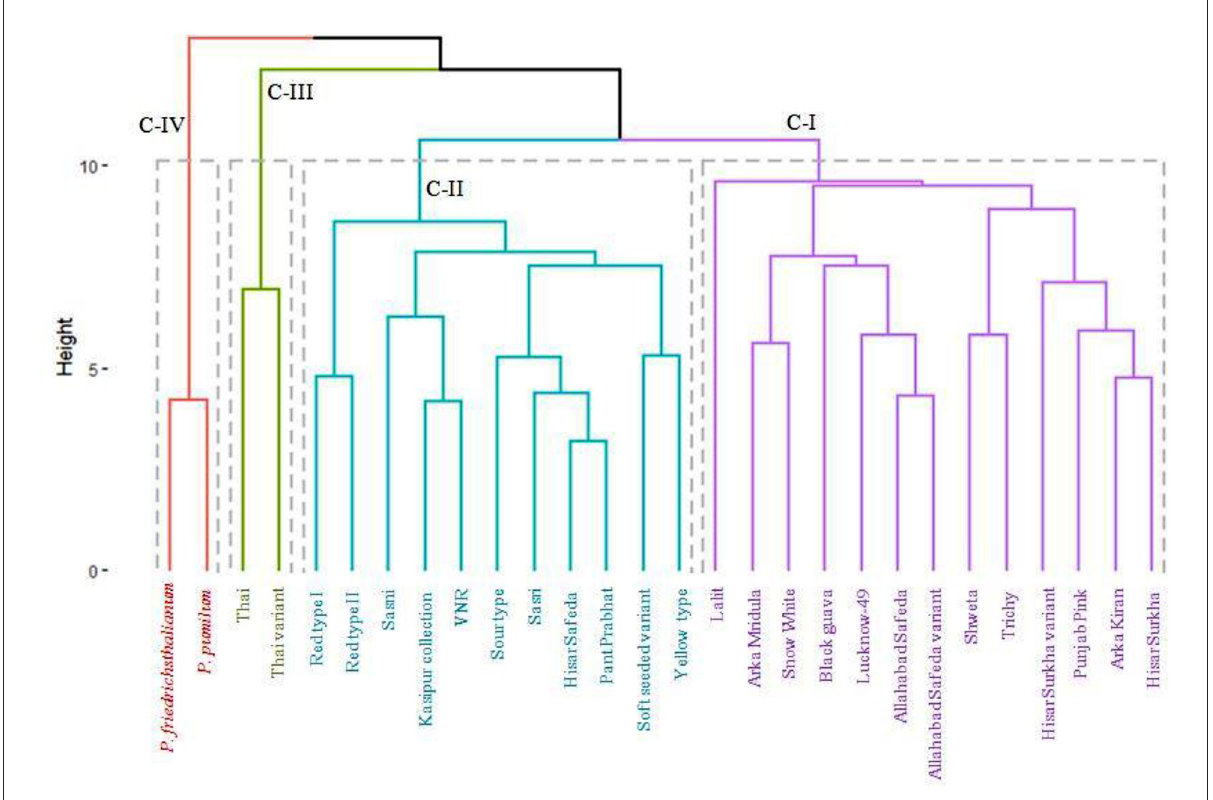
FIGURE6 Dendrogram for 28 guava germplasm based on 17 qualitative and 16 quantitative traits.